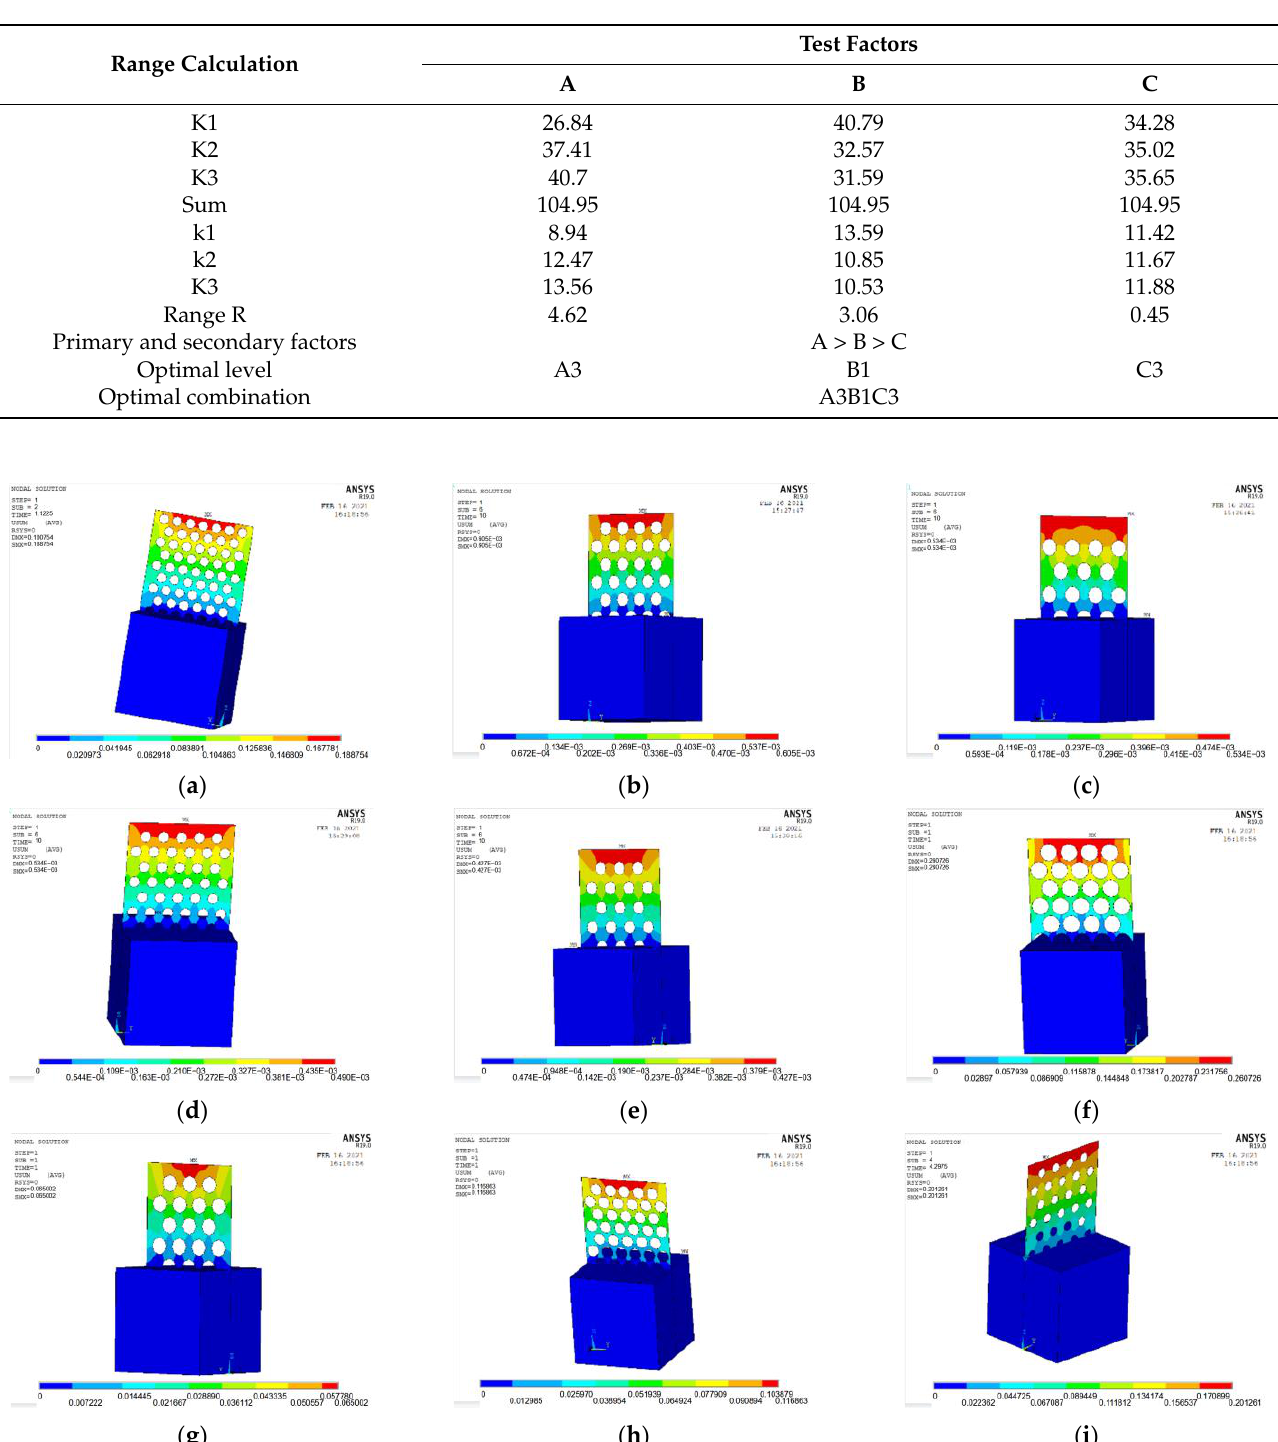
Table 9. Range analysis results of pull-out test of perforated steel sheet concrete.